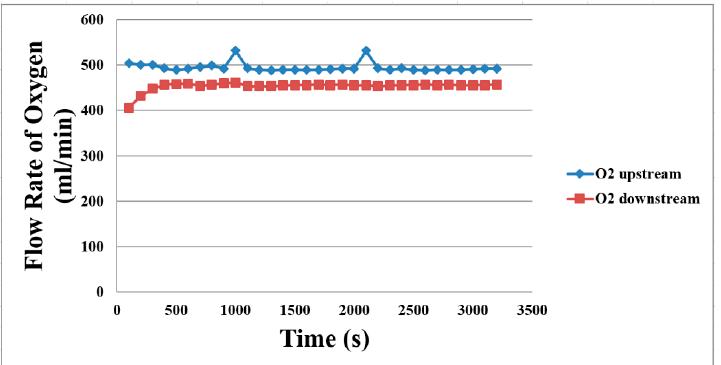
Figure 16. The oxygen side’s flow distribution during the proton battery